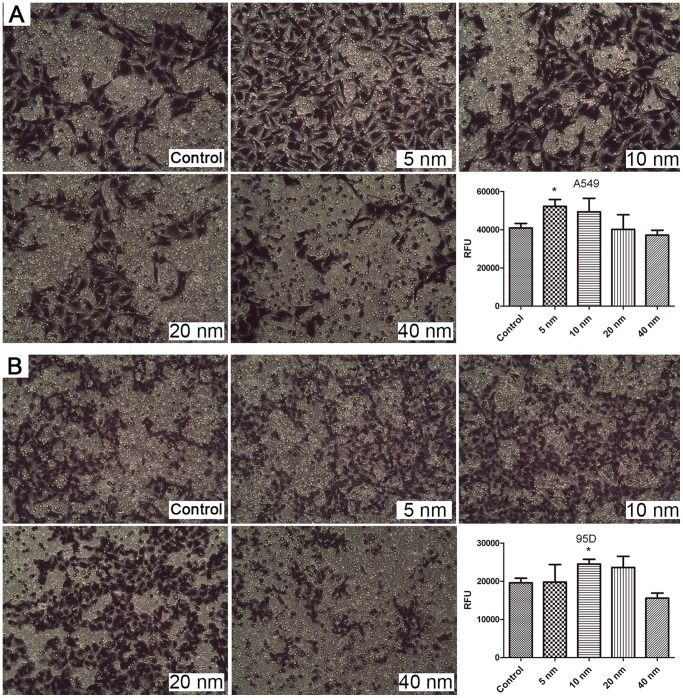
Optical images and fluorescence measurements of cell invasion on Au-NP treatment.The images represent A549 cells (A) and 95D cells (B) that have crossed the pores of the Matrigel invasion chamber and corresponding fluorescence intensity results. *P<0.05. Error bars indicate the SD values from three independent experiments.